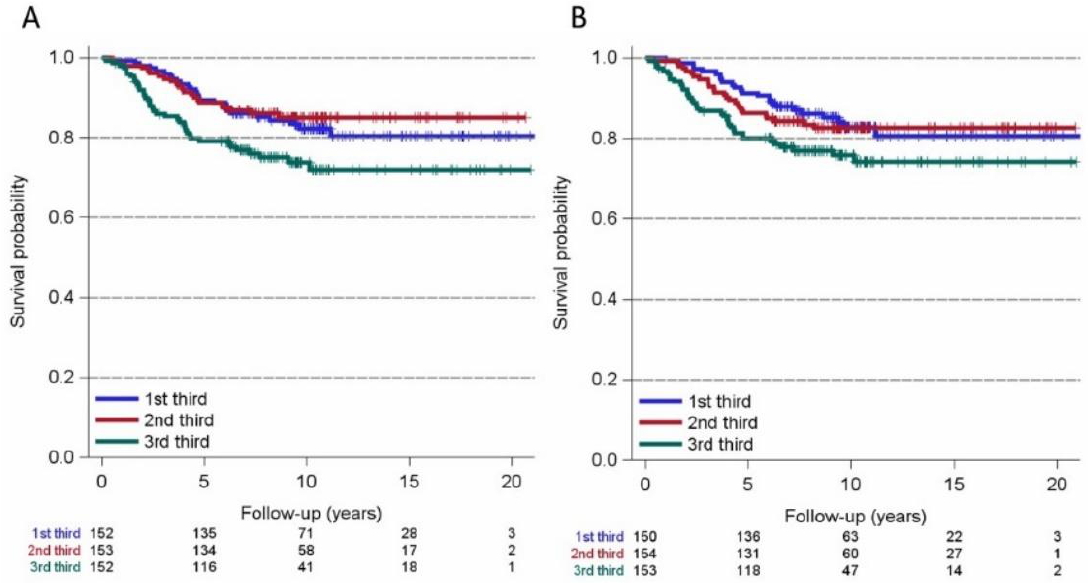
Figure 4. Kaplan–Meier curves for cutaneous melanoma-specific survival and thirds of the pan- immune inflammation value (PIV, ( A ): 1st third-PIV ≤ 219.73; 2nd third-PIV > 219.73 to 393.73; 3rd third-PIV > 393.73) and the neutrophil-to-lymphocyte ratio (NLR, ( B ): 1st third-NLR to 2.02; 2nd third-NLR > 2.02 ≤ 3; 3rd third-NLR > 3). The 3rd thirds of PIV ( A ) appear to be associated with poorer relapse-free survival (hazard ratio: 1.696, 95% CI 1.029 to 2.795). After adjustment for multiple confounders, including CM stage, CM subtypes, age, tumor thickness, and ulceration, the hazard ratios for the top PIV third (1.28, 95% CI 0.83 to 1.98) and NLR third (1.26, 95% CI 0.80 to 1.98) were substantially reduced with respect to CM-relapse-free survival (Table 2). Table 2. Cox proportional hazards regression model for cutaneous melanoma (CM) relapse-free survival and the total effects for the pan-immune-inflammation value (PIV) and neutrophil-to-lym- phocyte ratio (NLR) adjusted for potential confounders. Model and Variables